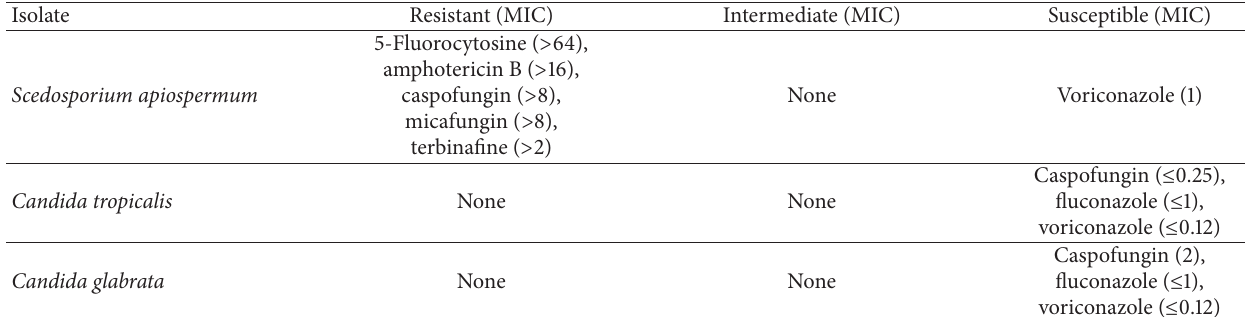
Table 2: Susceptibility testing of fungal isolates.